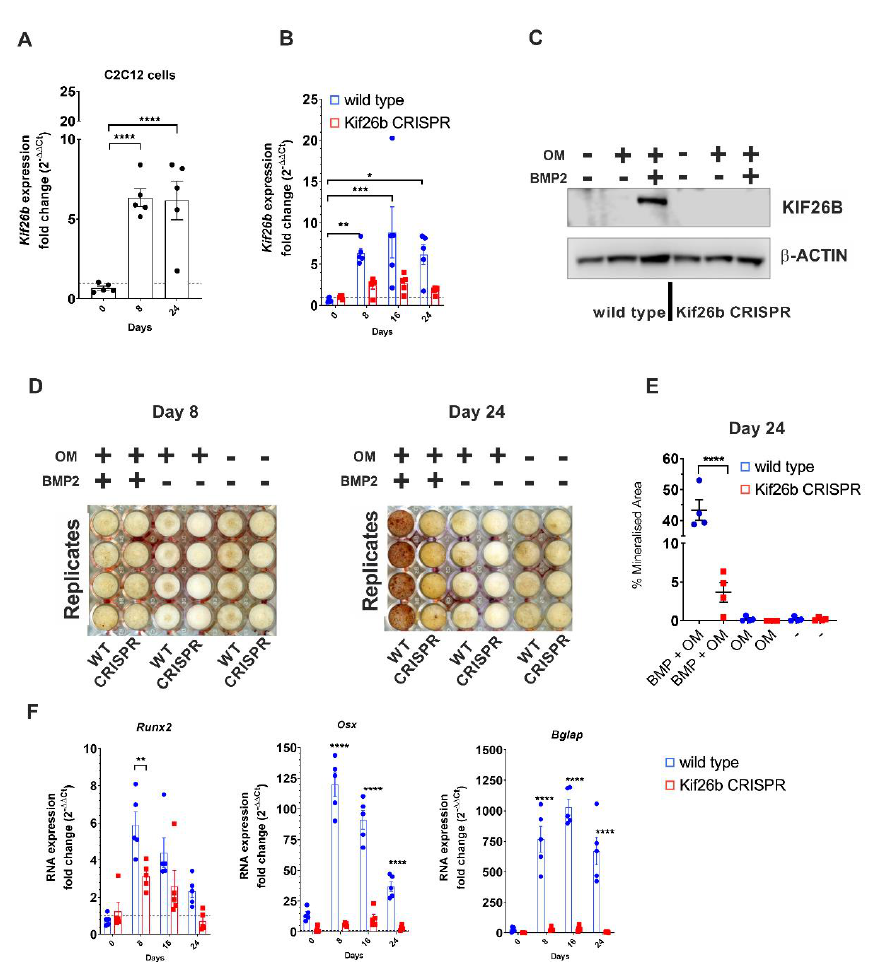
Figure 3. KIF26B is necessary for BMP-induced osteogenic differentiation of C2C12 murine myoblasts. ( A ) Kif26b mRNA expression is induced in C2C12 cells during BMP2 mediated differentiation. RT-qPCR was used to measure the expression of Kif26b at day 0 (confluency) relative to days 8 and 24 of differentiation when treated with 300 ng/mL BMP2 and osteogenic supplements. Technical replicates from a representative experiment (from 3 independent differentiations): each data point represents an individual well. Analyses were one-way ANOVA with Dunnett’s multiple comparisons; data are plotted as mean ± SEM. ( B ) Upregulation of Kif26b RNA is abrogated in Kif26b CRISPR C2C12 cells. RT-qPCR was used to measure the expression of Kif26b at days 8, 16 and 24 of differentiation when treated with 300 ng/mL BMP2 and osteogenic supplements relative to day 0 (confluency). Technical replicates from a representative experiment (from 3 independent differentiations): each data point represents an individual well. Analyses were one-way ANOVA with Dunnett’s multiple comparisons; data are plotted as mean ± SEM. ( C ) Upregulation of KIF26B protein is abrogated in Kif26b CRISPR C2C12 cells. KIF26B Western blot of WT and Kif26b CRISPR C2C12 myoblasts that were differentiated for 8 days in three different media. OM: media with osteogenic supplements. ( D , E ) In vitro mineralization is inhibited in Kif26b CRISPR C2C12 cells. ( D ) Alizarin Red S calcium staining of WT and Kif26b CRISPR C2C12 myoblasts after 8 and 24 days of differentiation. ( E ) Percentage mineralized area per well at day 24, as measured by percentage Alizarin Red S staining. Analyses were one-way ANOVA with Tukey’s post-hoc test. ( F ) Induction of osteogenic genes is prevented in Kif26b CRISPR C2C12 cells. Cells were cultured in media with osteogenic supplements and BMP2, and RNA levels of Runx2, Osterix (Osx) and Osteocalcin (Bglap) were measured by RT-qPCR. Analyses were two-way ANOVA with Sidak’s multiple comparisons. * p < 0.05, ** p < 0.01, *** p < 0.001, **** p <